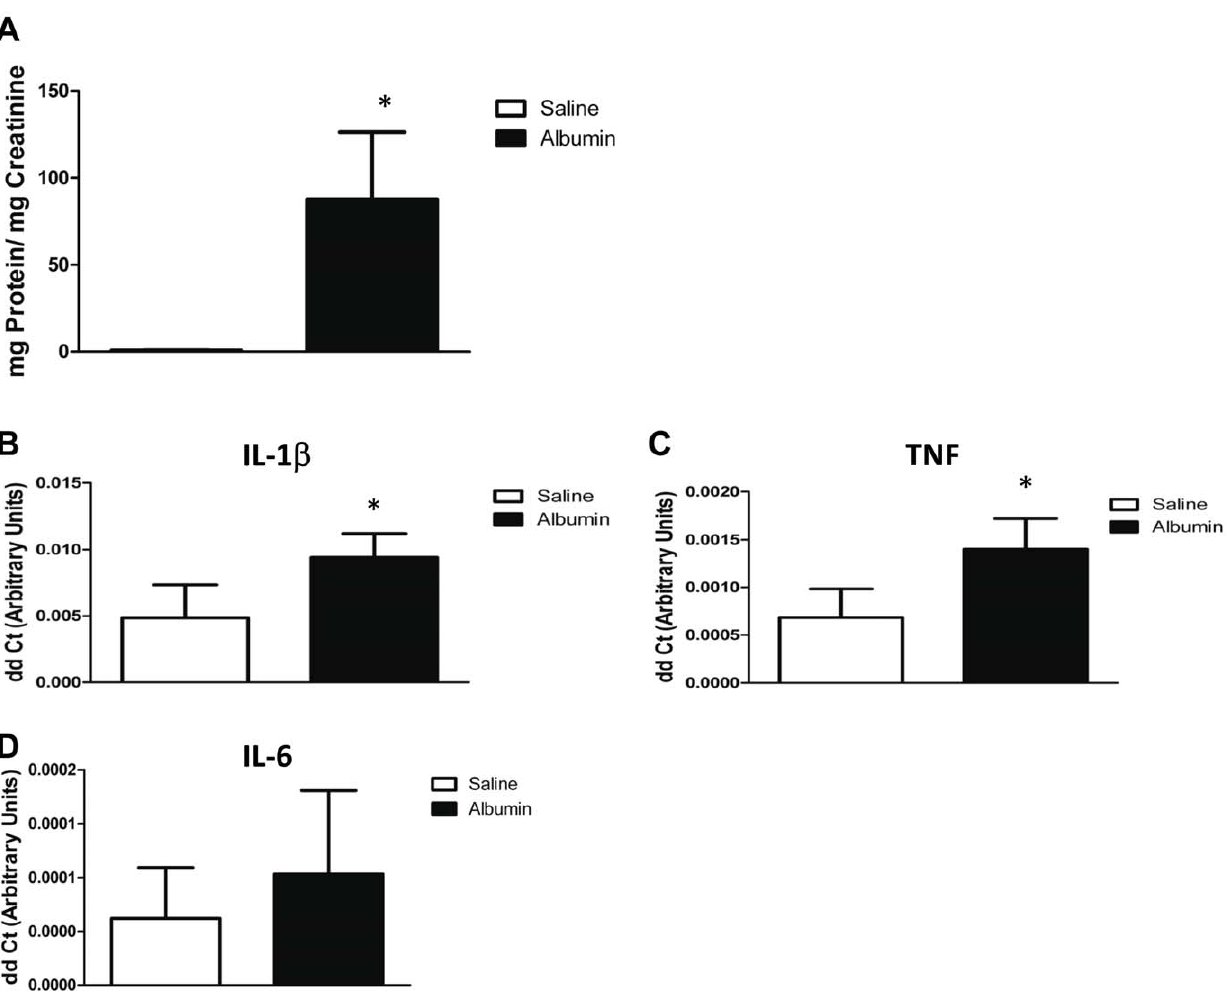
Figure 6. Albumin overload induces proteinuria and upregulates pro-inflammatory cytokine expression in isolated mouse glomeruli. A , Urinary protein normalized to urinary creatinine in mice injected with saline (open bar) or low endotoxin bovine serum albumin (BSA; closed bar; n=4 animals per group). * denotes P=0.004 compared to saline injected controls. B , IL-1 b expression in isolated glomeruli from mice injected with saline (open bar) or BSA (closed bar; n=4 animals per group). * denotes P=0.02 compared to controls. C , TNF expression in isolated glomeruli from mice injected with saline (open bar) or BSA (closed bar; n=4 animals per group). * denotes P=0.02 compared to controls. D , IL-6 expression in isolated glomeruli from mice injected with saline (open bar) or BSA (closed bar; n=4 animals per